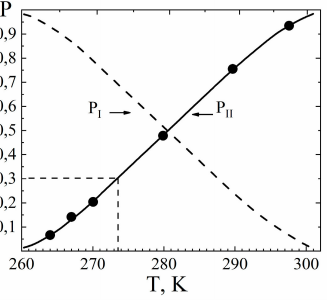
Figure 25. Temperature dependences of population p l (dashed line) and p h (solid line) for Li + ionic form of MF-4SC membrane at λ = 20.5 (adapted from [37,38]).